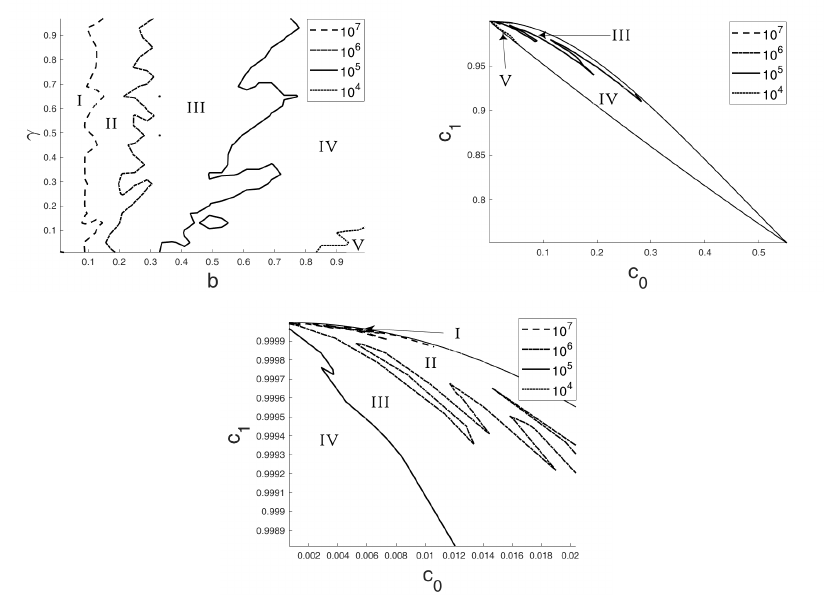
Figure 6. Level sets of the C 2 ( b , γ ) for q ∈ F h and h = 10 − 4 in terms of ( b , γ ) ( upper left ) and in terms of ( c 0 , c 1 ) ( upper righ t), and a close up of the upper left region in this last figure is in the lower figure. Regions separated by level sets are indicated: Region I corresponds to the potentials with a stability constant larger that 10 7 , region II corresponds to those with a stability constant lower that 10 7 but larger than 10 6 , and so on.